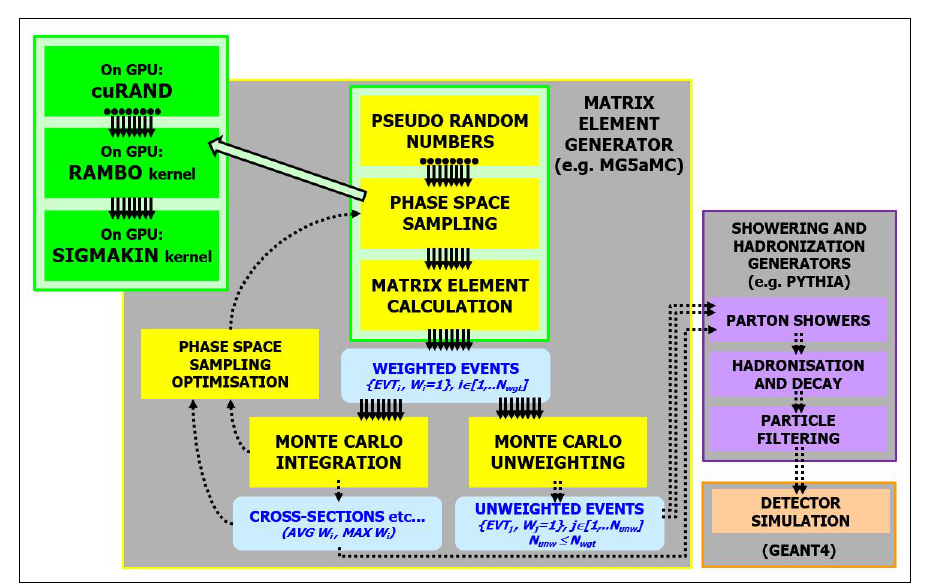
Figure 4. Schematic representation of the computational anatomy of a matrix element generator. The three green blocks in the top-left corner represent the software components included in the standalone simplified workflow application described in this paper. A detailed explanation is provided in the